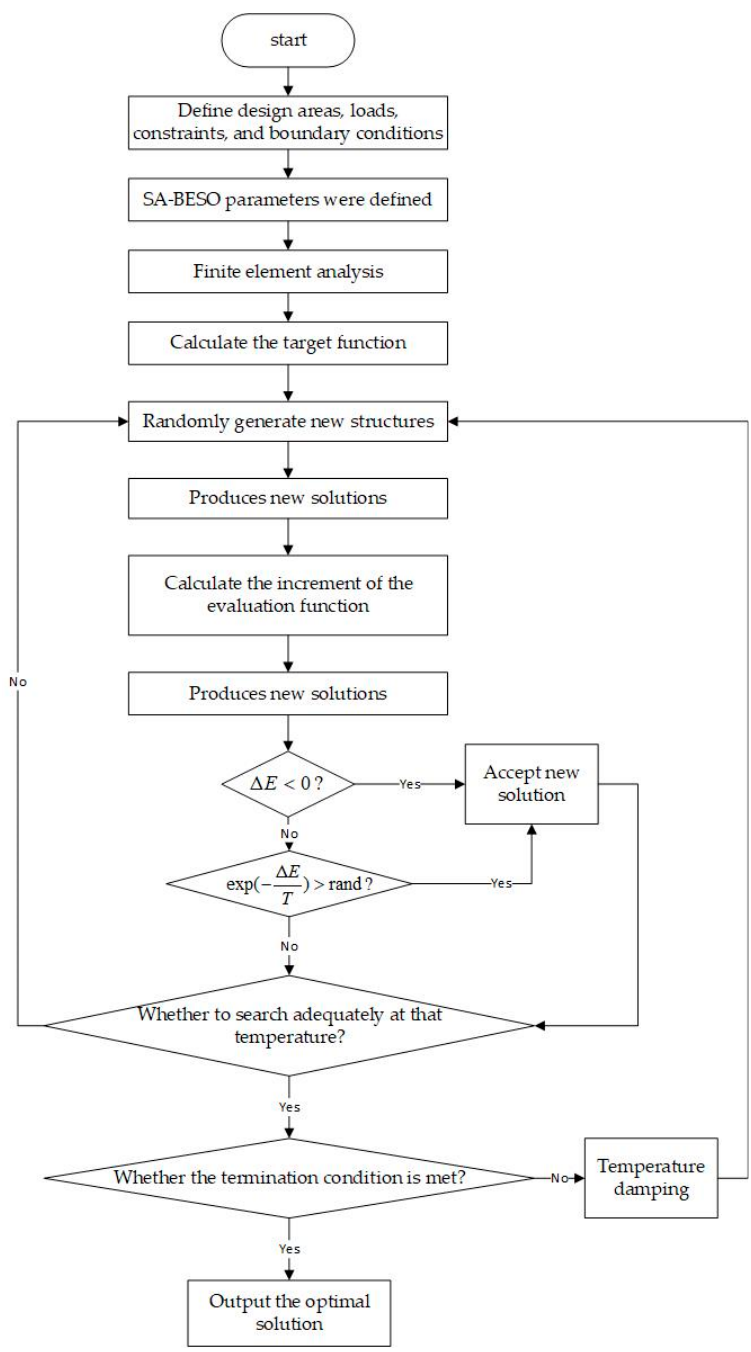
Figure 1. Flowchart of the SA-BESO method.